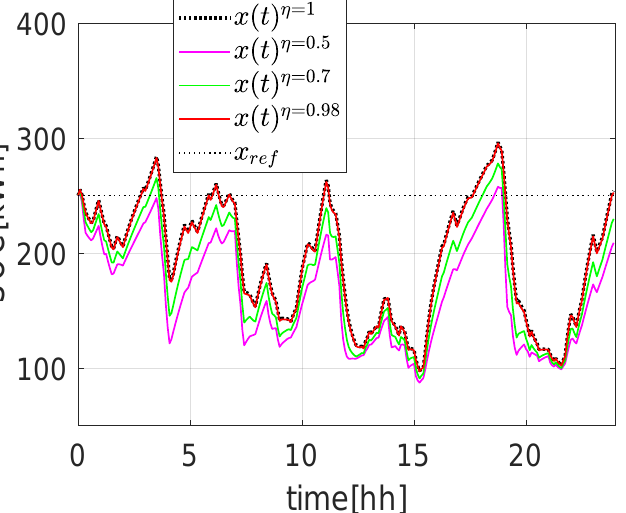
Figure 8. Power evolution at POC with different power conversion losses factors η ∈ { 0.5,0.7,0.98,1 } .